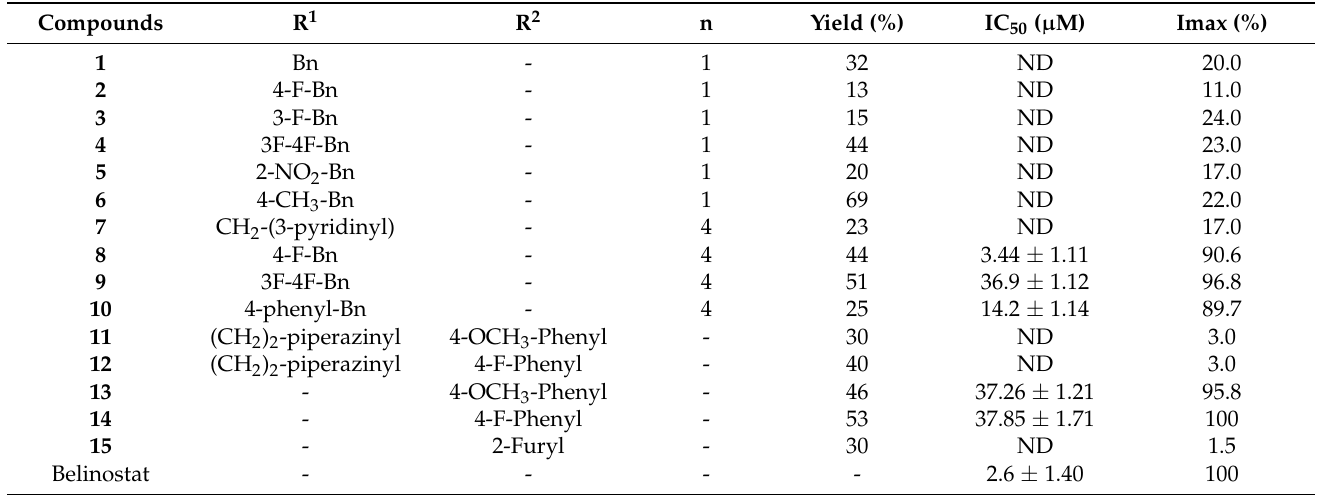
Table 1. Synthesis and antiproliferative activities of hydroxamate derivatives ( 1 – 15 ) against MCF-7 cell